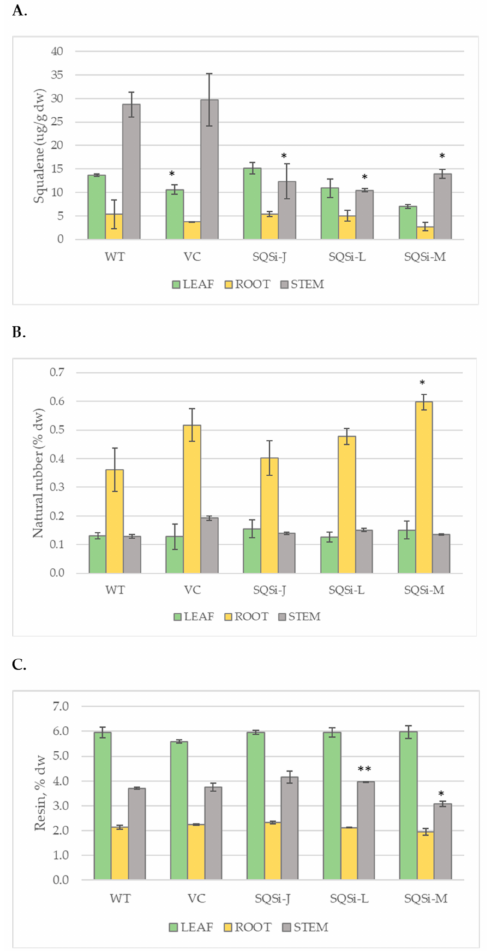
Figure 2. Secondary metabolites in guayule. Concentration of targeted metabolites in 5-month- old guayule plant tissues: WT = wildtype, VC = vector control, squalene synthase downregulated lines SQSi -J, -L, -M represent 3 independent transformation events. ( A ) Squalene (ug/g dw), deter- mined from purified acetone extracted tissue samples using gas chromatography-mass spectrometry (GC-MS). ( B ) Natural rubber (% dw), and ( C ) resin (% dw), quantified by accelerated solvent extrac- tion. Average value of 3 biological replicates; error bars are +/ − standard error; symbol * denotes significantly different from WT at p < 0.05; ** at p <